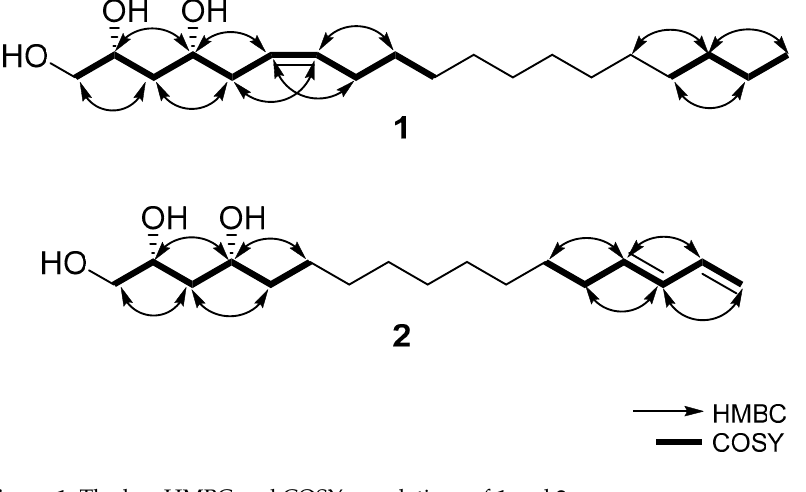
Figure 1. The key HMBC and COSY correlations of 1 and 2 . Table 1. NMR spectroscopic data for compounds 1 and 2.